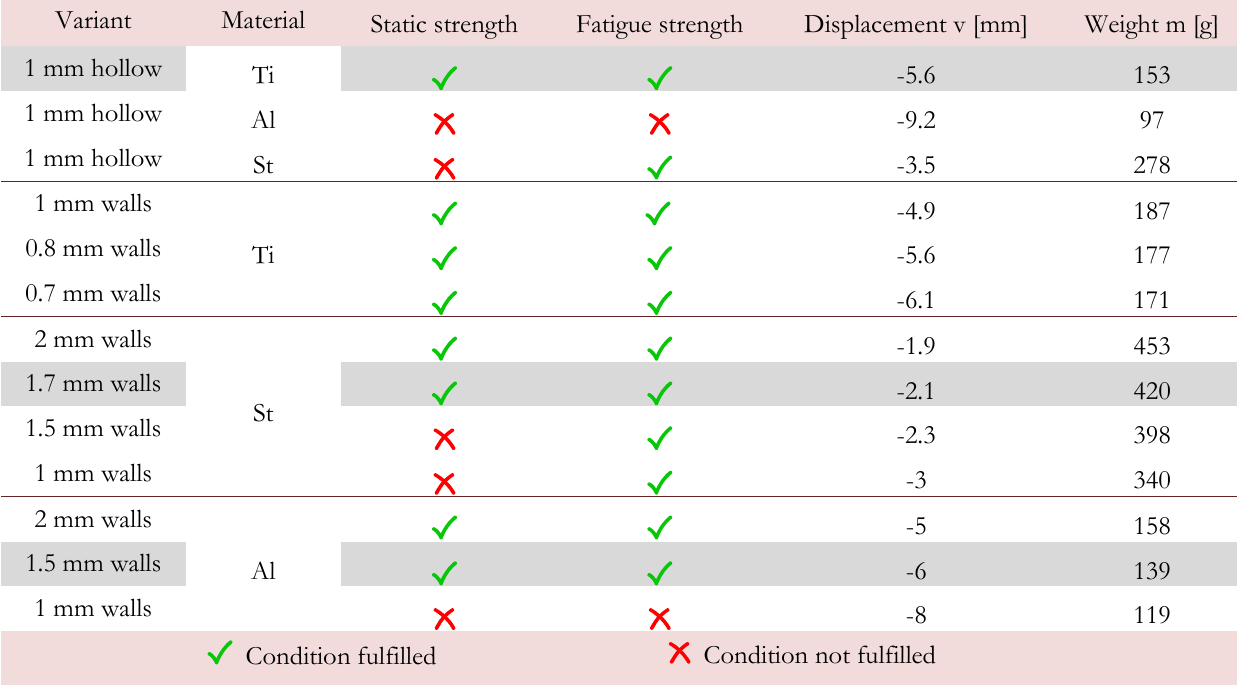
Table 1: Results of part optimisation based on numerical